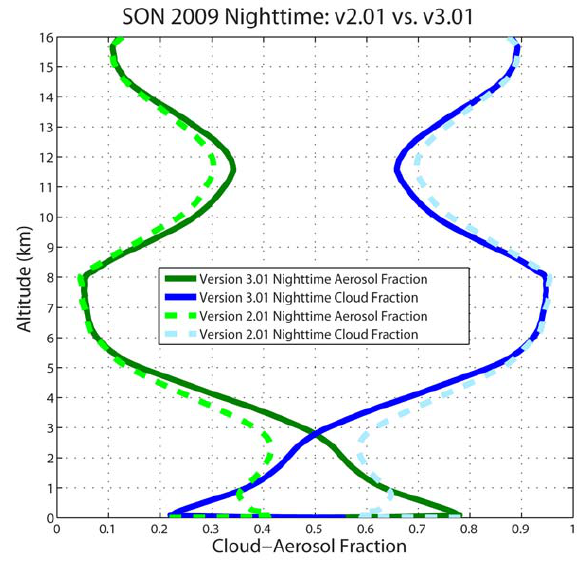
Fig. 1. Relative fraction of clouds and aerosols identified in the CALIOP V2 data products (dashed lines) versus the CALIOP V3 data products (solid lines) for daytime measurements during September, October, and November 2009. Below ∼ 4km, the V3 cloud fraction decreases sharply and continuously with respect to V2. Similarly, the V3 aerosol fraction shows the same dramatic increase with respect to the V2 aerosol fraction. The changes be- tween 4km and 2.5km are due entirely to the repair of the V2 cloud clearing bug. Responsibility for the changes below 2.5km is shared between the cloud clearing bug and the new aerosol base height identification